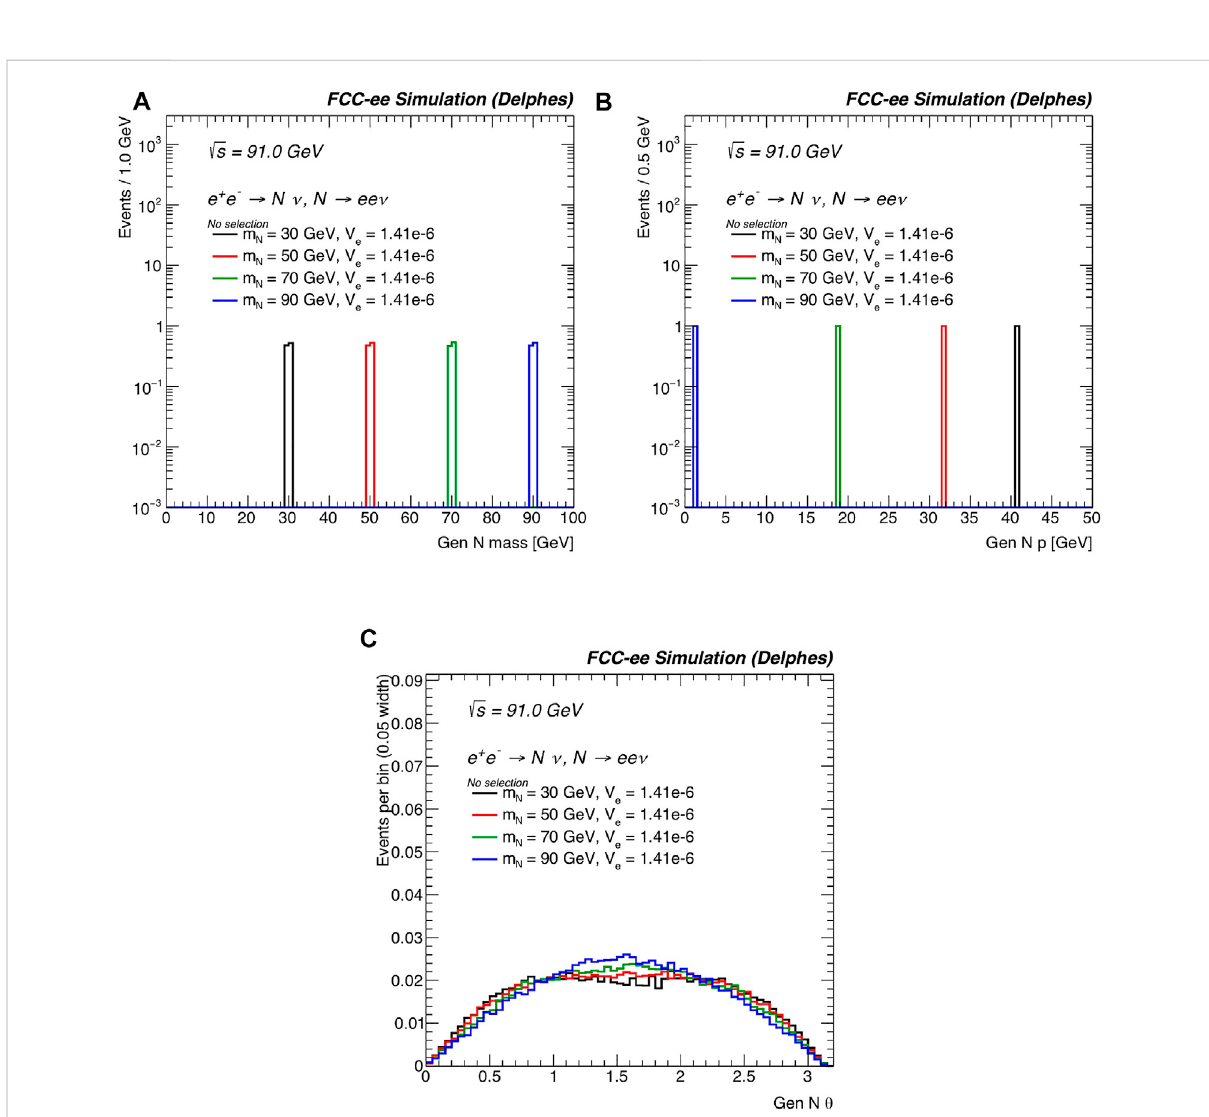
FIGURE 12 Fortheprocesses e + e − → N ] e + N ] e with N → e + e − ] e + e + e − ] e at the magnitude of N ’ s three-momentum in the lab frame, and (C) the polar angle of N with respect to the beam axis in the lab frame are shown, for representative HNL masses and representative active-sterile mixing | V eN | = 1.41 × 10 – 6 . The distributions are normalized to unit